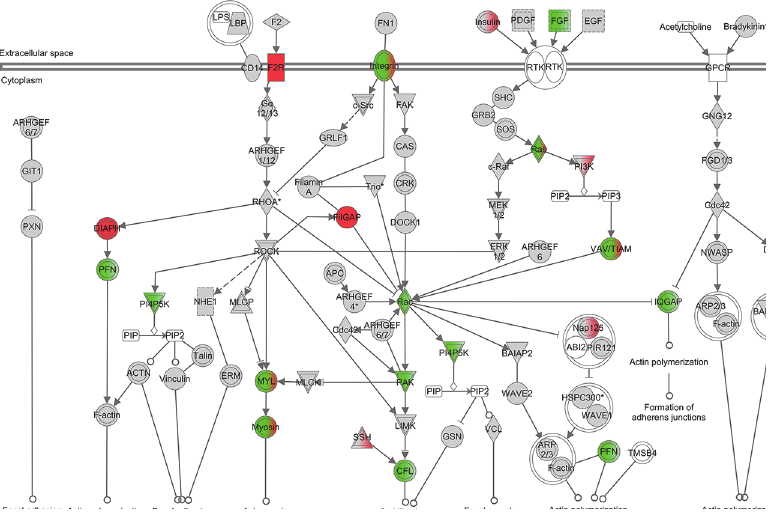
Fig 3. Differential mRNA expression in quadriceps muscle from Cfl2 deficient mice compared to wild- type littermates for actin cytoskeleton. Red indicates increased expression and green indicates decreased expression. The brighter the red or green color, the more significantly altered is the expression. When both colors are present for the same gene, it indicates that some isoforms of the gene are upregulated while others are downregulated. White or gray boxes indicate no significant differential expression.